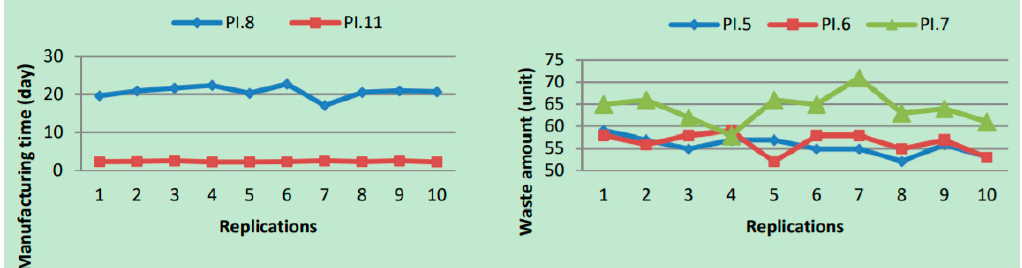
Figure 18. Comparison of two simulation models in terms of manufacturing time and waste.